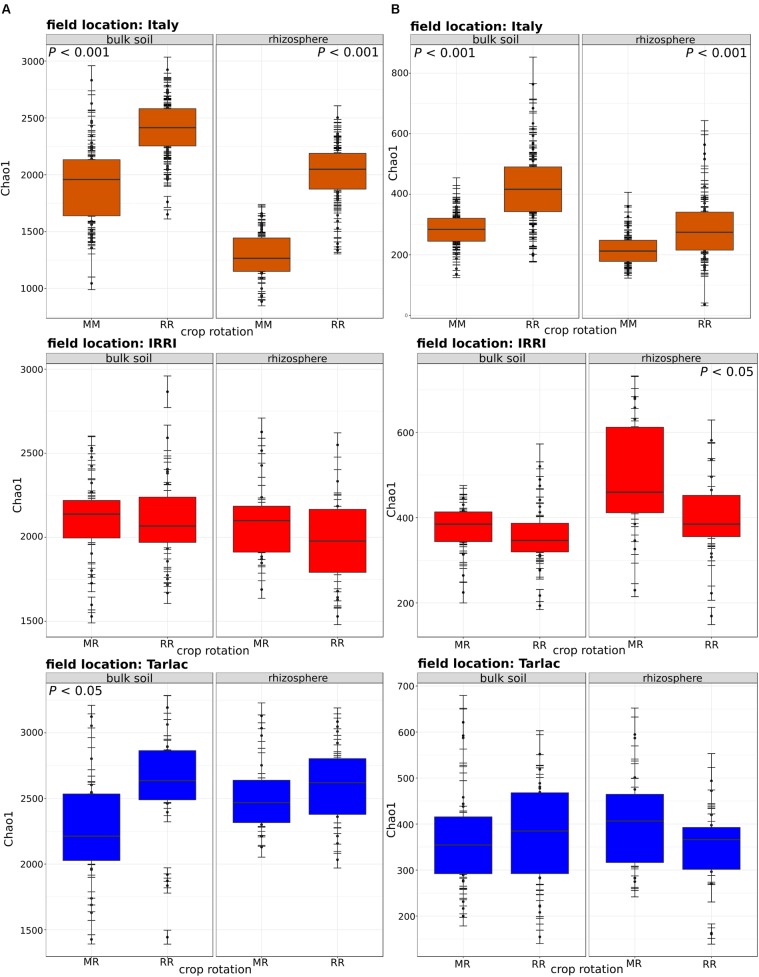
Box plots showing the influence of crop rotation on bacterial (column A) and fungal alpha diversity (column B) within each field location and compartment. Each box plot shows alpha diversity based on the Chao1 diversity index and includes all samples treated with or without straw and collected at different time points. The median as well as the 25th and 75th percentile of the samples is presented, individual data points outside of this range are given as mean ± standard deviation of four replicate samples. Significant differences due to crop rotations within one compartment (bulk soil or rhizosphere) are noted.